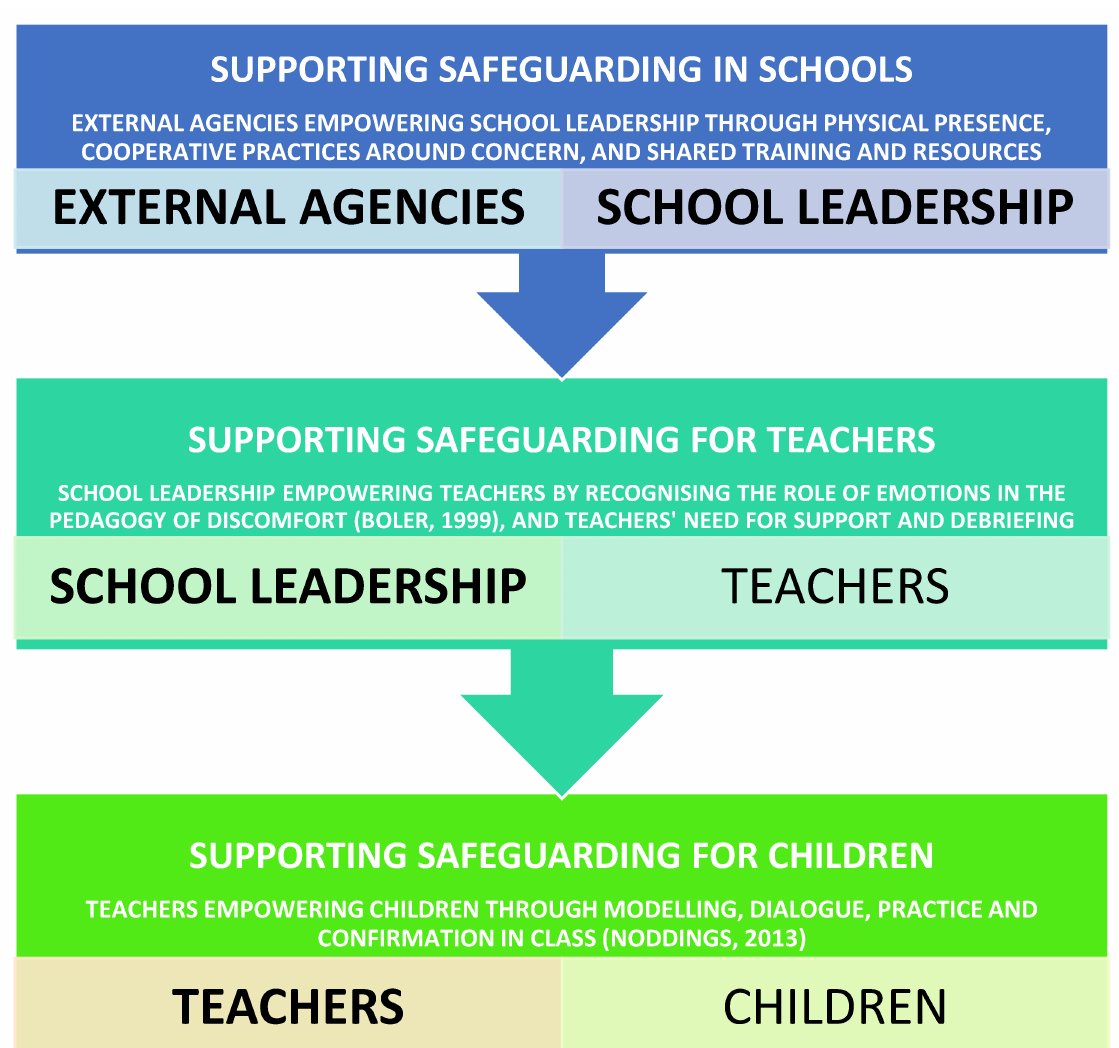
Figure 1. Addressing asymmetrical power relations and emotions in safeguarding (Source: Author,